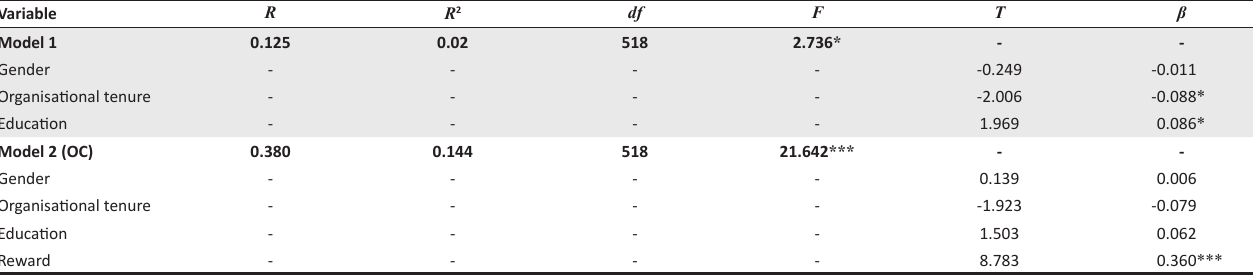
TABLE 6: Regression analysis of the influence of reward on organisational commitment. Variable